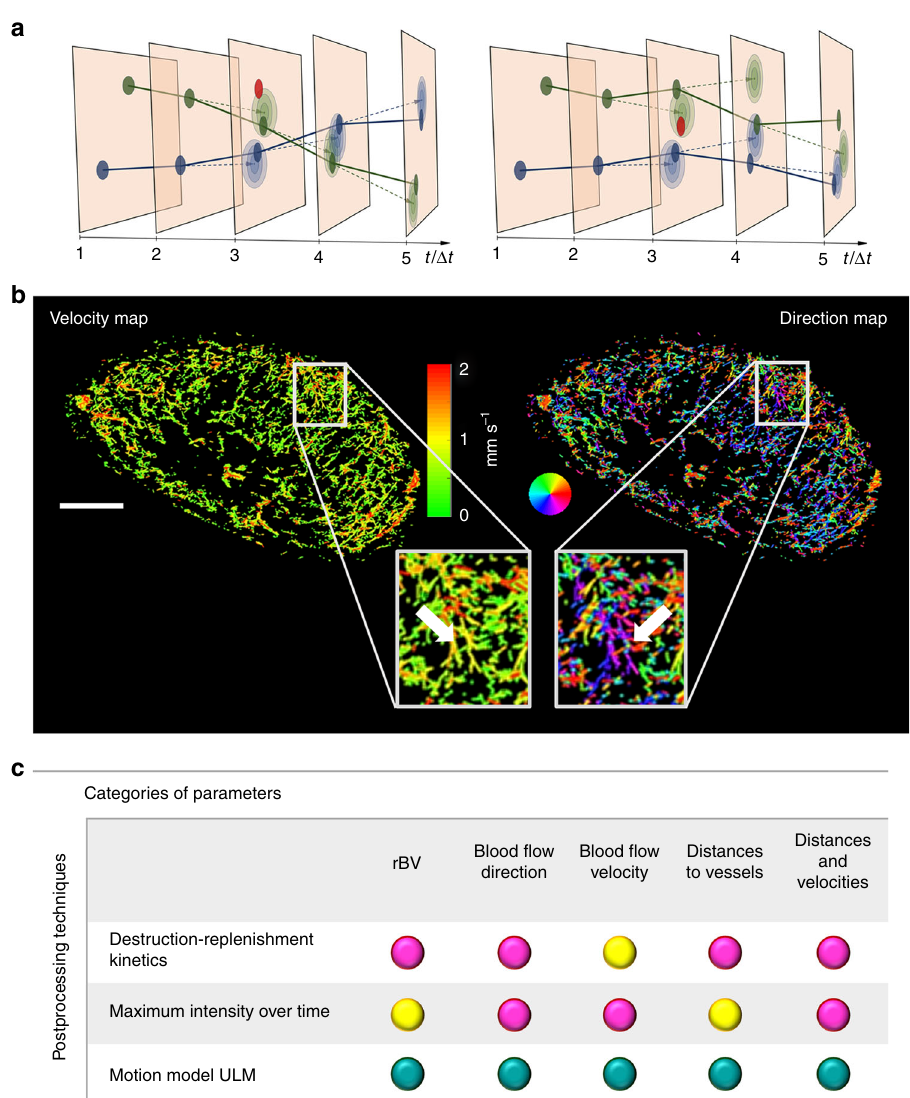
Fig. 1 Motion model ultrasound localization microscopy (mULM): Principle, examples, and assessable parameters. a Sketch illustrating the principle of mULM. The fi lled circles mark the positions of detected MB. The red circles indicate detected MB supposed to be false alarms. The colors (blue/green) indicate the association of the MB to different tracks. One possible association of MB tracks is shown in the left diagram, another one in the right. The lighter ellipses indicate the probability density functions for the positions predicted by a linear motion model. From these, the likelihoods of the detected positions for an association are determined. The Markov Chain Monte Carlo Data Association (MCMCDA) algorithm searches for the association that maximizes the posterior probability. This also accounts for prior probabilities, like, e.g., the probability of false alarms. Taking these analyses into account, in this example, the left association is more probable than the right one. b Super-resolution ultrasound images of an A431 tumor provide detailed information on the microvascular architecture including insights into vascular connectivity and the number of vascular branching points (see arrows in magni fi cations). Functional information such as MB velocities (left image) and MB fl ow directions (right image; color-coding illustrating the direction of fl ow according to the colored circle) can be determined for each individual vessel and evaluated together with the morphological characteristics. Scale bar = 1 mm. c Overview of the parameter classes obtained with mULM and their accessibility with standard contrast-enhanced ultrasound methods (turquoise dot: quantitative and robust assessment of a parameter is possible; yellow dot: the information is available but its assessment is less robust, less accurate, or not quantitative; magenta dot: the parameter cannot be obtained with the respective